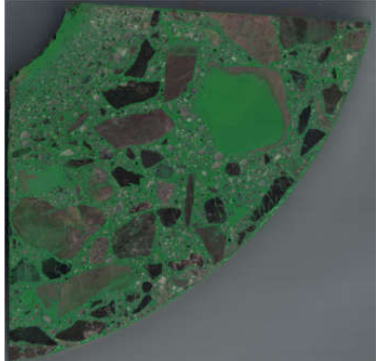
Figure 5. Scan of spun concrete element cross section after matrix dyeing (scale 1:1).